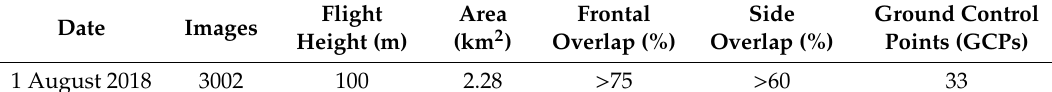
Table 1. Unmanned aerial vehicle (UAV) photogrammetry data acquisition of the study site.